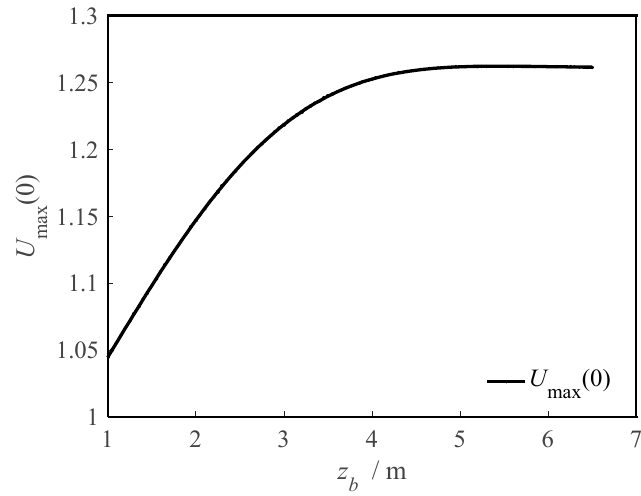
Figure 5. Influence of upper soil thickness on the horizontal displacement of pile head.